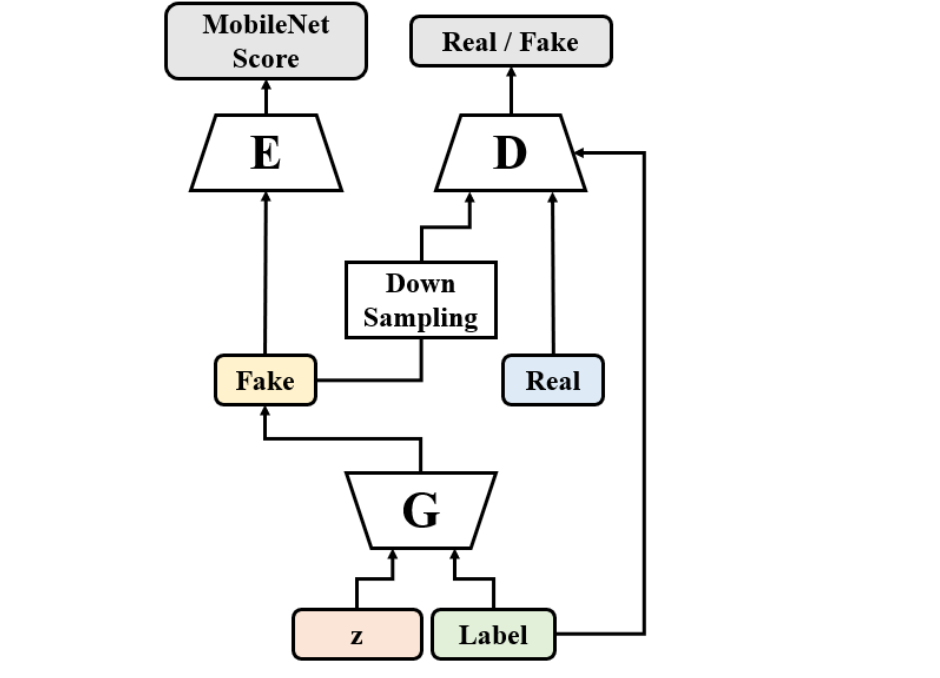
Figure 1. The proposed HRGAN model. The z is a random latent vector sampled from a normal distribution, Label is a class vector expressed by an one-hot vector, X indicates training images, and therefore, G( z , Label ) becomes synthetic images.